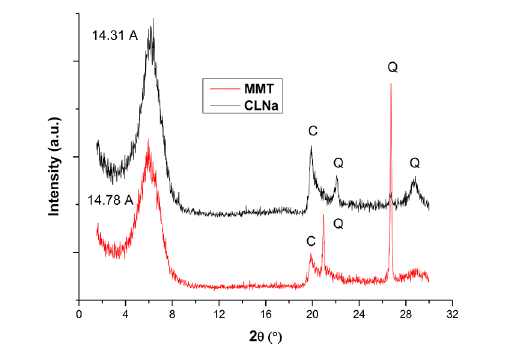
Figure 2. X-ray diffractograms of CLNa and MMT.